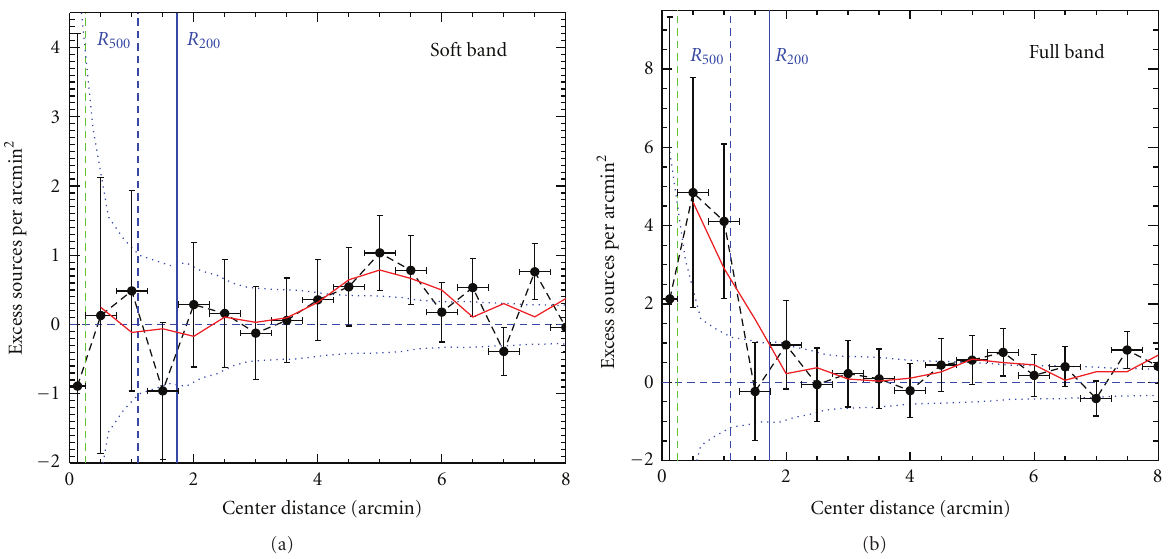
Figure 6: Background-subtracted radial distributions of excess X-ray sources for the soft band (a) and full-band (b). Dotted blue lines indicate the 1 σ uncertainties about the mean background counts (blue dashed). Data points and the black dashed line display the measurements in each of the independent radial bins, whereas the red solid line shows the boxcar smoothed radial trend. The green dashed vertical line on the left shows the 15 (cid:3)(cid:3) radius below which the measurements are biased due to the comparable spatial resolution of XMM- Newton . The blue vertical lines mark the average cluster radii R 500 (dashed) and R 200 (solid).